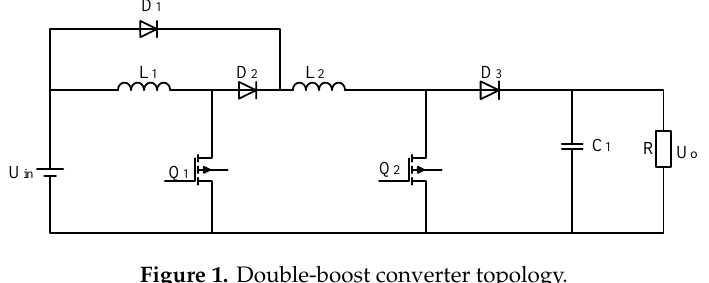
Figure 1. Double-boost converter topology.